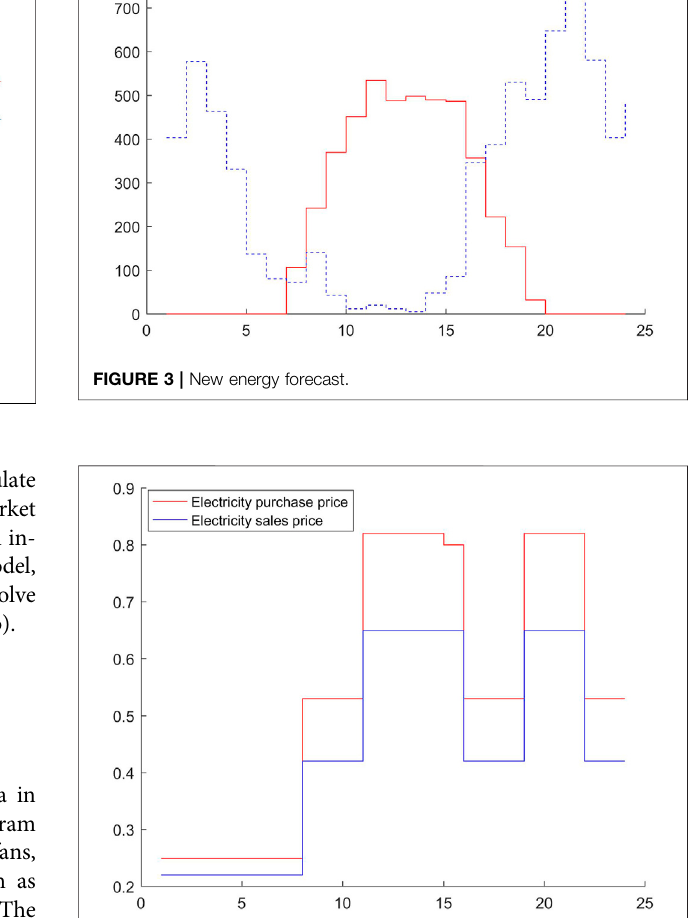
FIGURE 4 | Electricity purchase and sale price by time